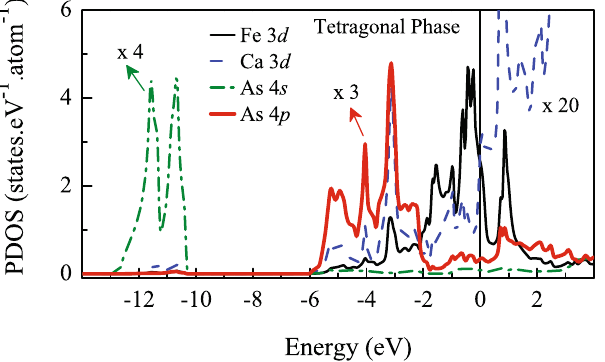
Figure 3. Calculated partial density of states of Ca, Fe and As atoms in the tetragonal phase (total contributions). The PDOS of As is multiplied by 3 and Ca PDOS by 20 to show their contribution clearly. Here, ‘0’ in energy scale denotes the Fermi level, ε F